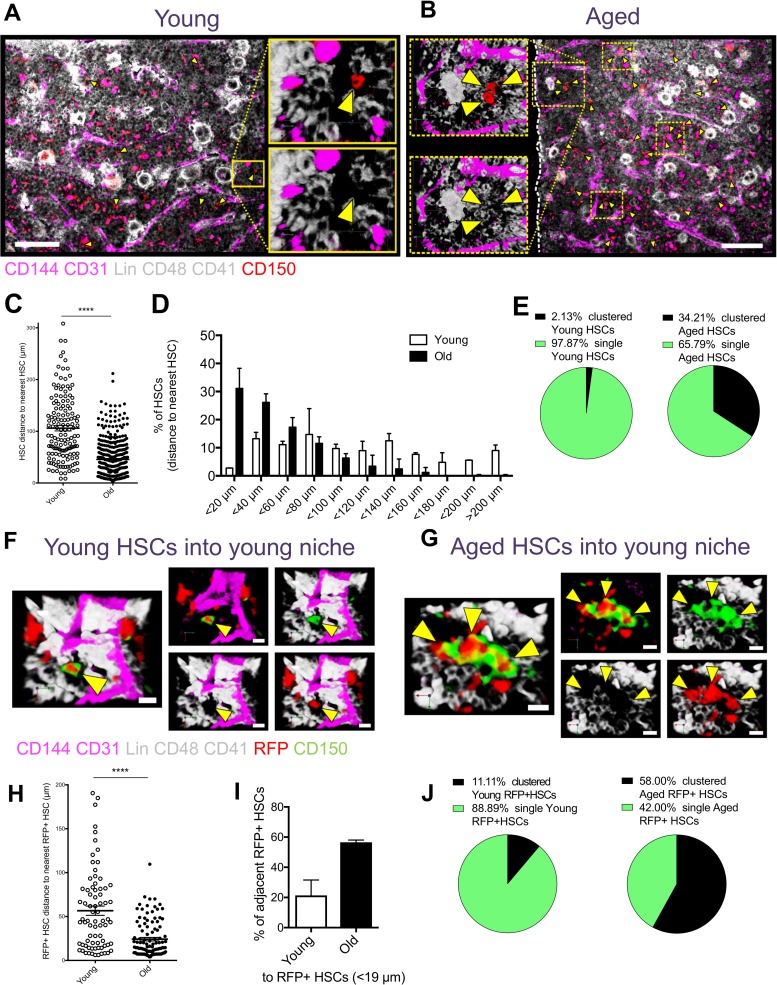
HSCs are found in clusters in bone marrow in aged animals.(A, B) Representative 3D confocal pictures of a whole-mount femur from a young (panel A) and an aged (panel B) mouse. HSCs are indicated by yellow arrowheads. Dashed lines in panel B highlight clustered HSCs. Lineage markers CD41 and CD48 are shown in white; CD150 in red and endothelial cells (IV injected VE-Cadherin CD144 and PECAM-1 CD31) are in magenta. (C) Distance between HSCs in young and aged femurs. (D) Percentage of HSCs located in 20 μm intervals from the closest HSC in young and aged femurs. (E) Pie charts depicting the percentage of HSCs found in clusters (2 cells or more adjacent to each other) or as single cell in young and aged mice. Imaging data refer to 27 young and 14 aged longitudinal shaved whole-mount cross-sections from 2 young and 2 aged mice; 144 young HSCs and 394 aged HSCs. (F, G) Representative 3D confocal pictures of whole-mount femur analyses from young recipient mice transplanted with young (panel A) and aged (panel B) RFP+ HSCs. Donor-derived RFP+ HSCs are marked by yellow arrowheads. Lineage markers CD41 and CD48 are shown in white, CD150 in green and endothelial cells (IV injected VE-Cadherin CD144 and PECAM-1 CD31) are in magenta. All donor-derived cells are RFP+ (red). (H) Distance between donor-derived RFP+ young and aged HSCs in the femurs of young recipient mice. (I) Percentage of donor-derived RFP+ young and aged HSCs located in 20 μm intervals from the closest donor-derived RFP+ HSC in the femurs of recipient mice. (J) Pie charts depicting the percentage of donor-derived RFP+ young and aged HSCs found in clusters (2 cells or more adjacent to each other) or as single cell in the femurs of young recipient mice. Imaging data refer to 8 young and 4 aged longitudinal shaved whole-mount cross-sections from 2 young and 2 aged mice; 75 young HSCs and 108 aged HSCs. The primary data the figure is based on are provided in S1 Data. HSC, hematopoietic stem cell; IV, intravenous; Lin, lineage; RFP, red fluorescent protein.